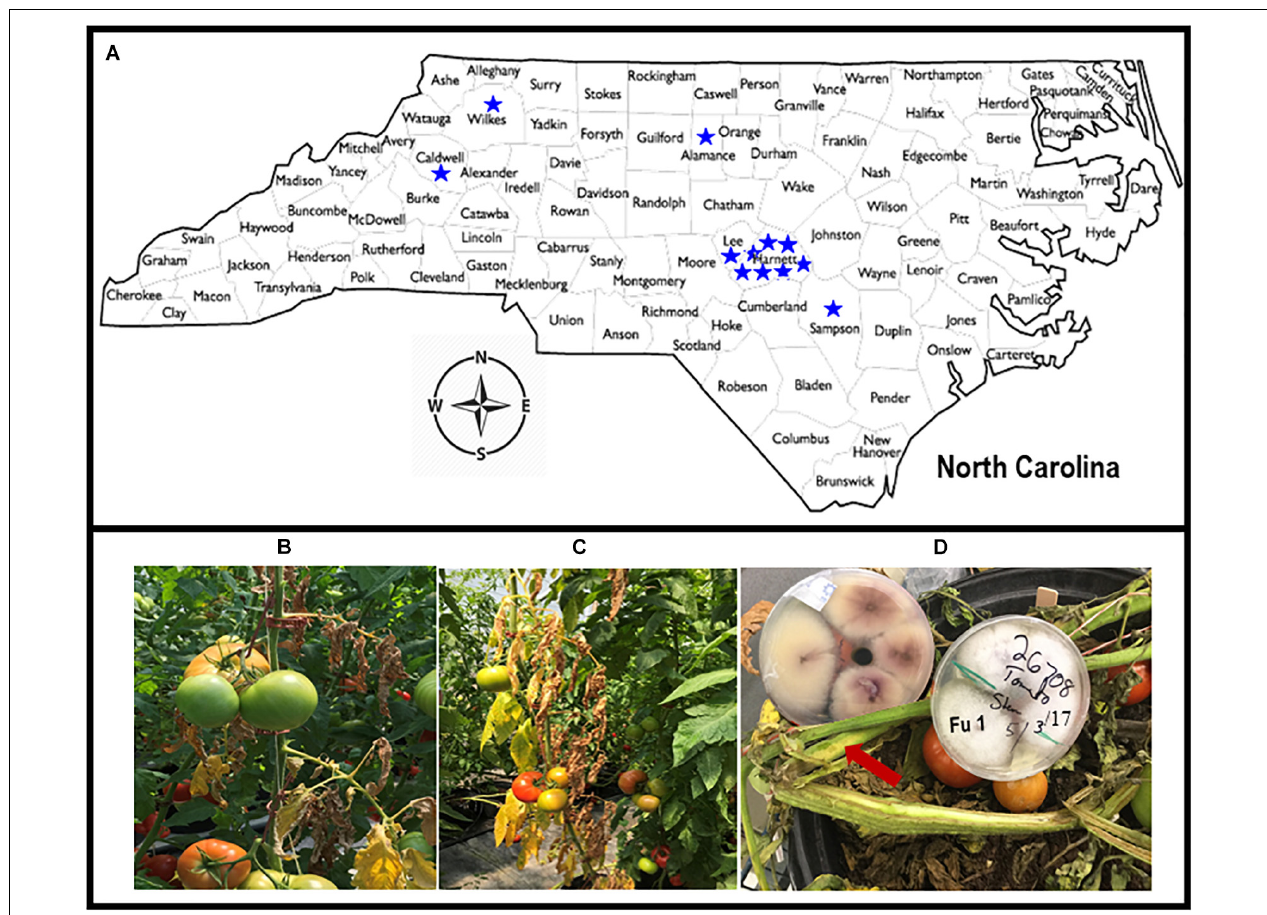
FIGURE 1 | Map of North Carolina showing locations from where diseased tomato plants were collected from 12 greenhouses in six counties (A) . Tomato plants showing yellow and wilt symptoms (B,C) . The presence of pinkish or brown discoloration or browning of the vascular systems (with arrow) caused by Fusarium oxysporum f. sp. lycopersici (FOL) on tomato cultivars that were grown in the greenhouses in North Carolina, and creamy and light pink to purple mycelial grown on acidic potato dextrose agar plate containing isolate Fu 1 of FOL (D)